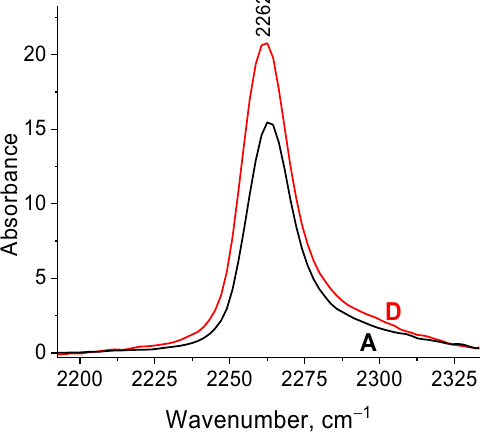
Figure 9 . FTIR spectra of deuterochloroform adsorbed on samples A and D . Figure 9. FTIR spectra of deuterochloroform adsorbed on samples A and D .